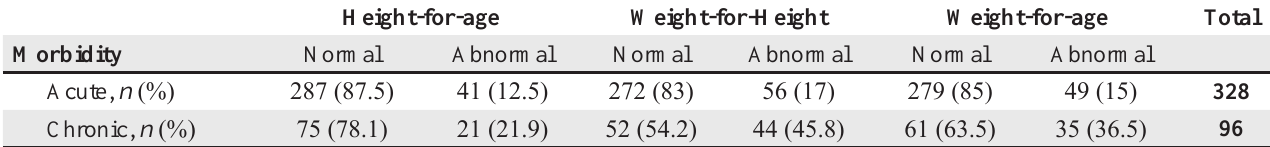
Table 2 : Anthropometric measurement (normal or abnormal) for acute or chronic morbidity. Height-for-age Weight-for-Height Weight-for-age Total